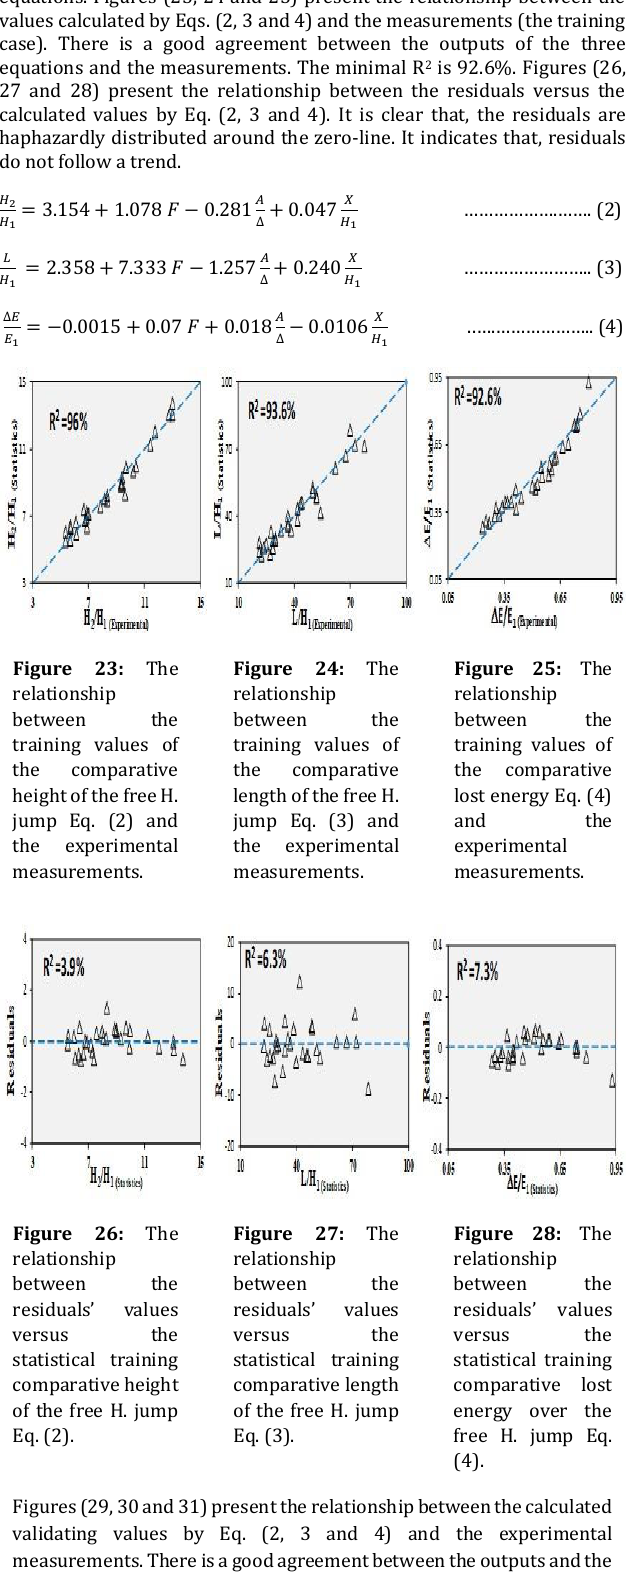
Figure 22: The relationship